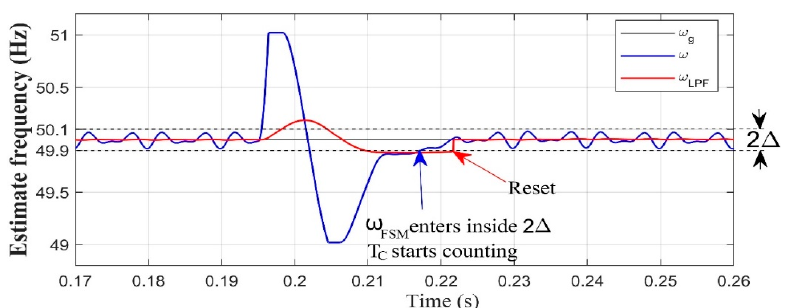
Figure 15. ω and ω (cid:2896)(cid:2900)(cid:2890) transient responses to an 80% depth voltage sag happening at t = 0.195 s for a grid voltage distorted by a 5th harmonic with 3% amplitude.